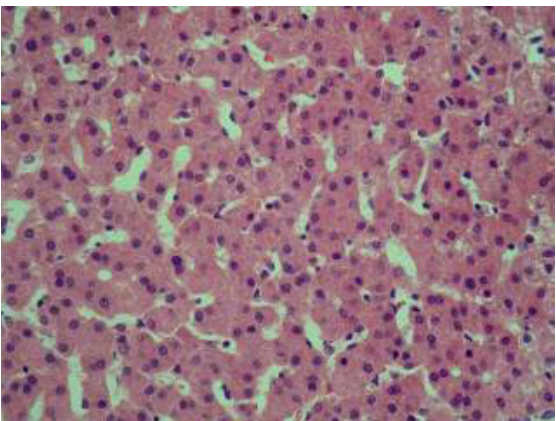
Fig. 13. Piglet liver, the 2 nd group, 70 nd day of test. Widen- ing of internal lobular capillary blood vessels. H&E. x